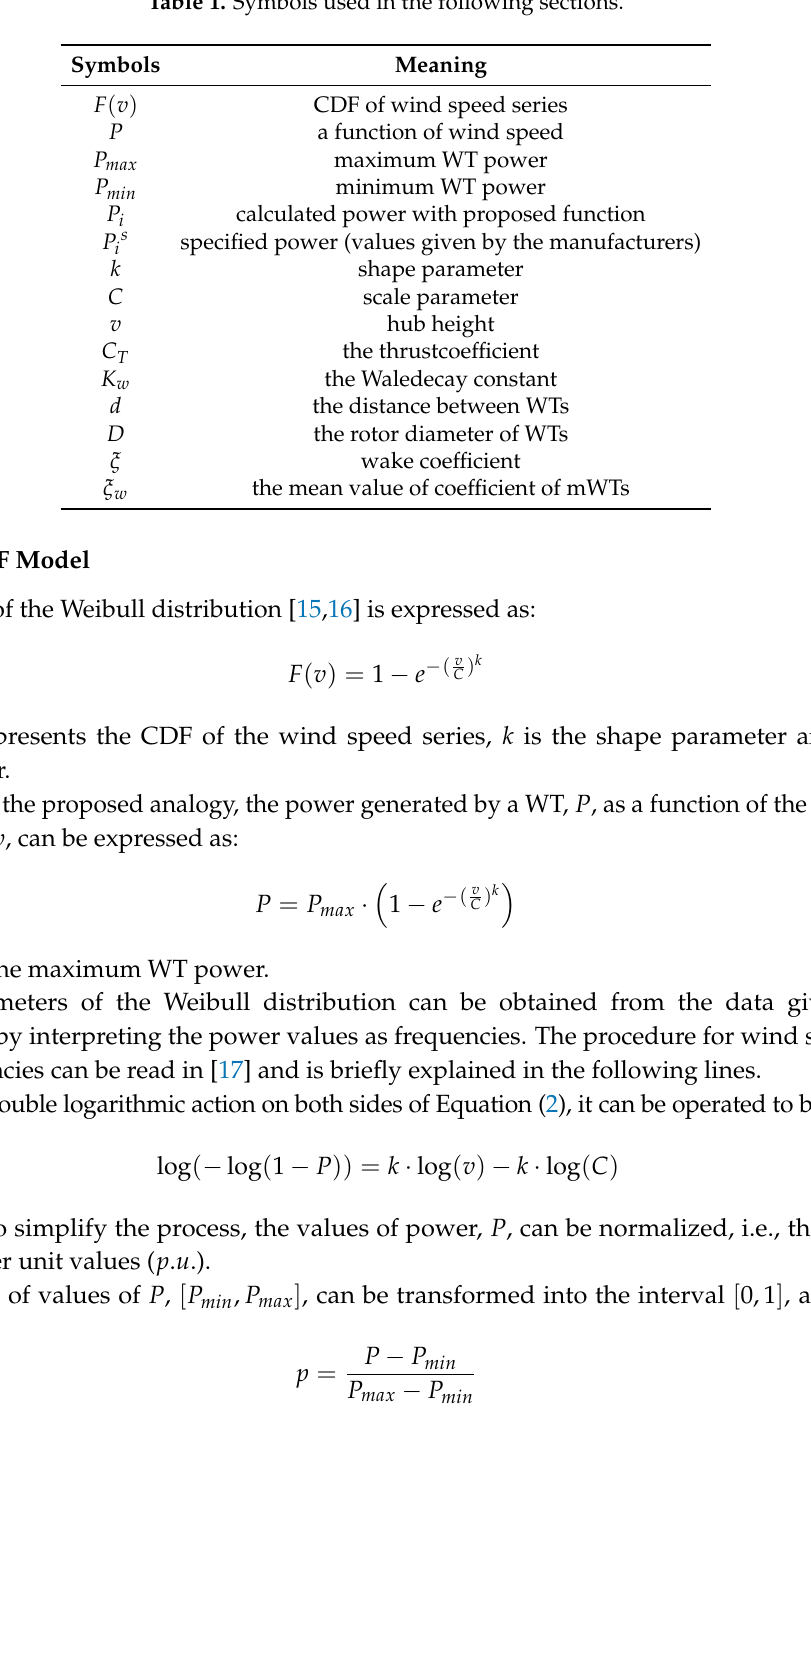
Table 1. Symbols used in the following